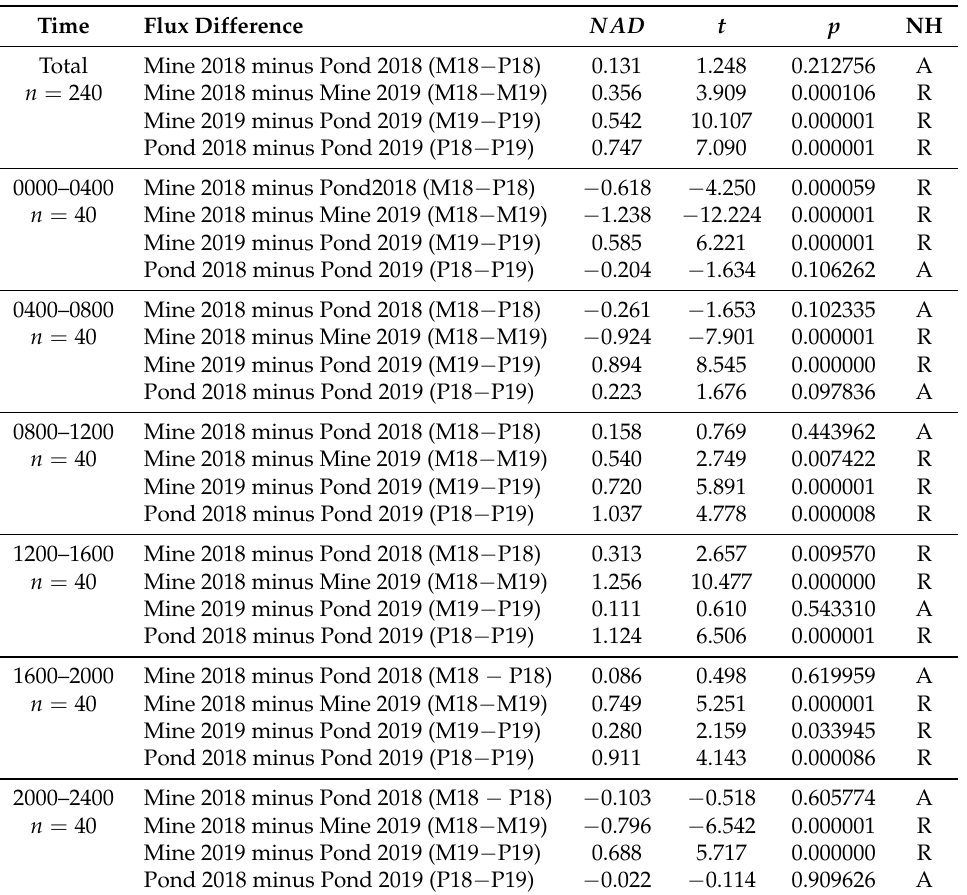
Table 2. Normalized Average Difference ( NAD ) of WRF simulated advective flux ( F CH t -test to check the null hypothesis (NH) that there was no difference in average advective fluxes ( F CH between two cases in question; accept (A) meant there was no difference, while reject (R) meant